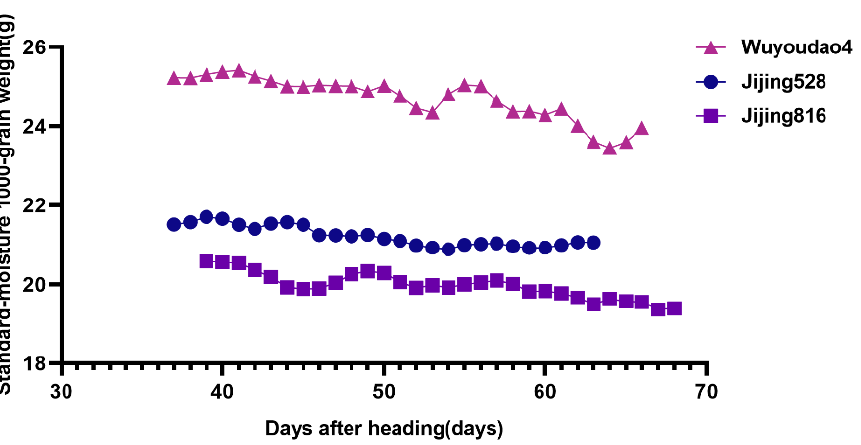
Figure 2. The relationship between standard-moisture 1000-grain weight of rice and days after heading was tested in 2019.